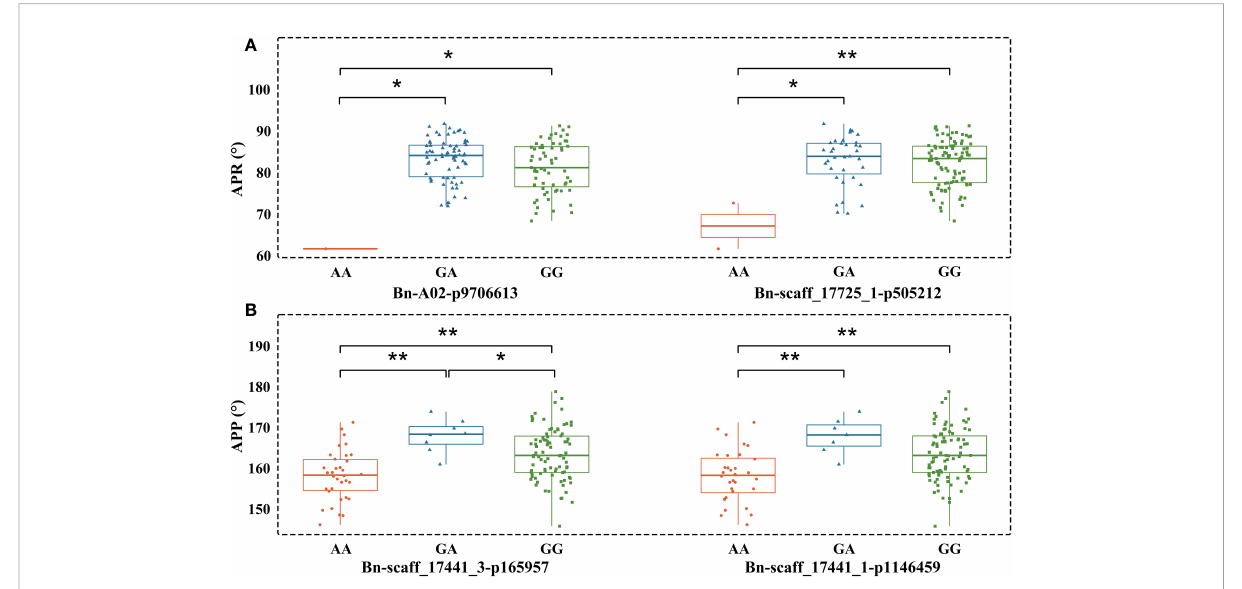
FIGURE 5 Boxplots showing the association between alleles of two peak SNP markers and pod orientation. (A) Angle of the pod on raceme (APR) and corresponding SNP alleles; (B) Angle of the pod on pedicel (APP) and corresponding alleles. All statistical associations are marked with *(at P <0.05) and with ** (at P